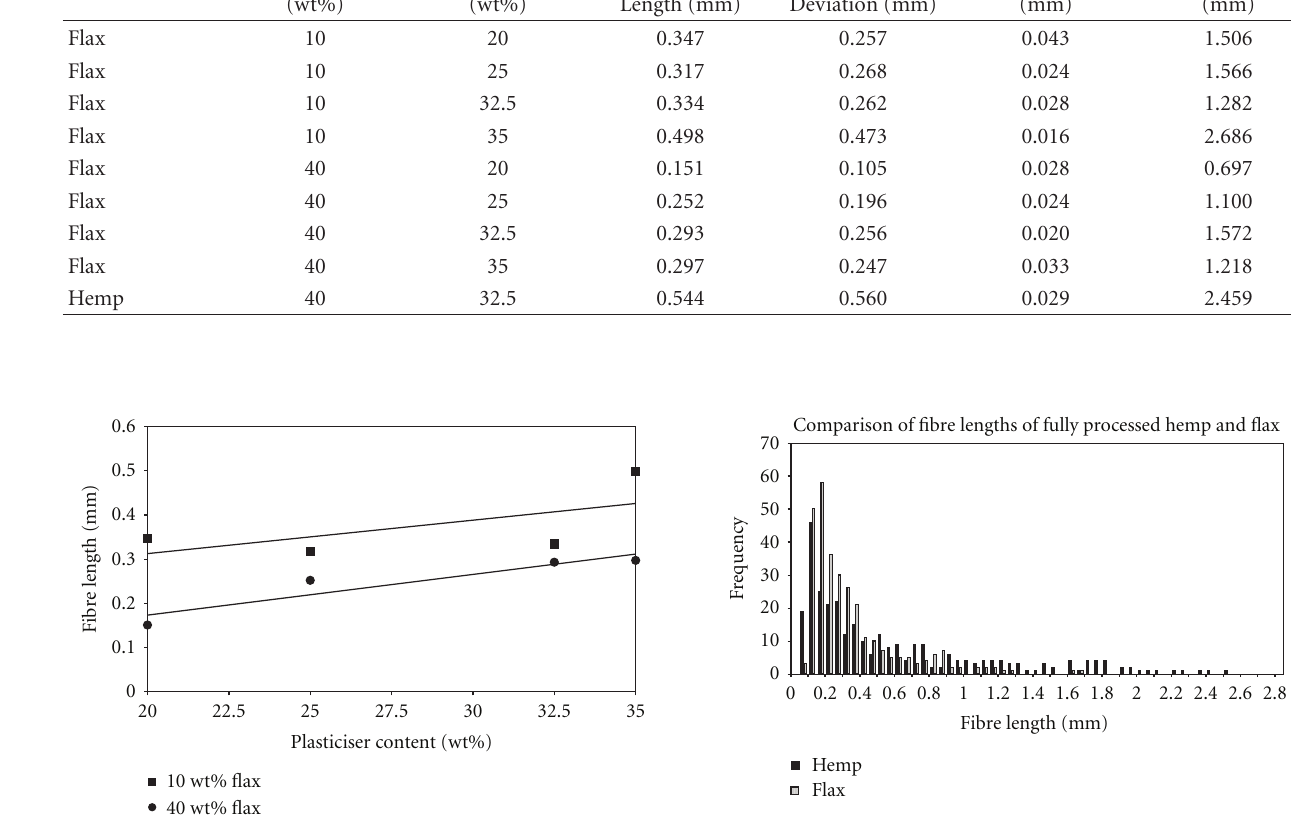
Figure 2: Mean lengths of flax fibers after full processing. The fibers were extracted from composites with 10 and 40 wt% fiber content and with variable plasticizer content.